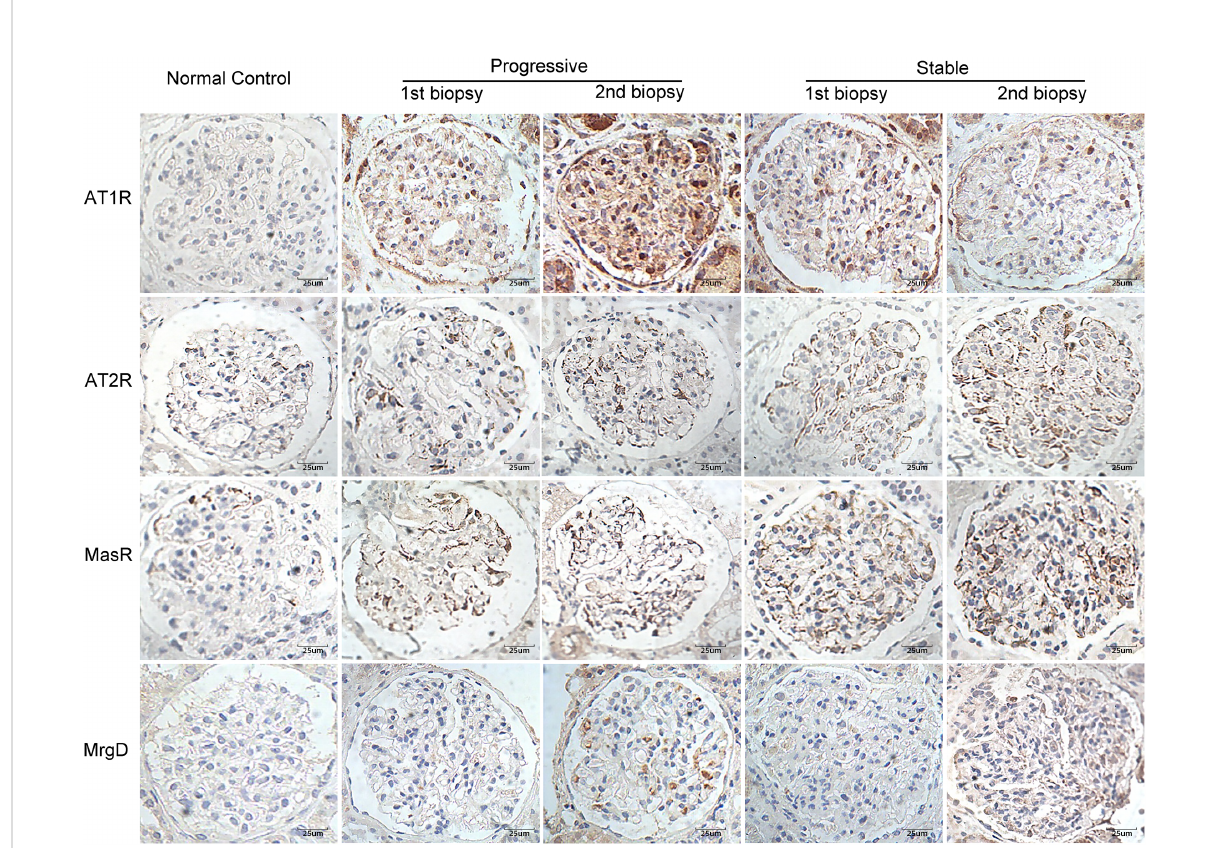
FIGURE 2 Immunohistochemical staining for AT1R, AT2R, MasR, and MgrD in patients with IgA nephropathy in the stable and progressive groups (×400). AT1R, angiotensin II type 1 receptor; AT2R, angiotensin II type 2 receptor; MasR, Mas receptor; MgrD, Mas-related G protein-coupled receptor, member